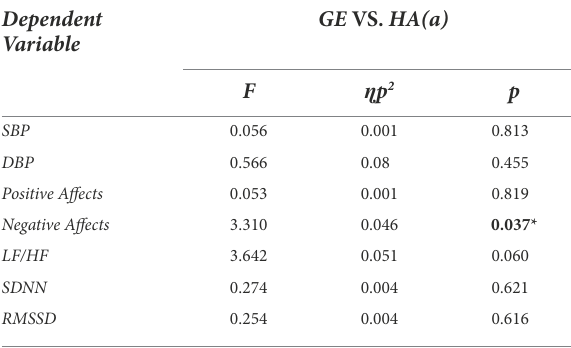
TABLE 4 The effect of green exercise and horticultural activities on the variation of the dependent variable.